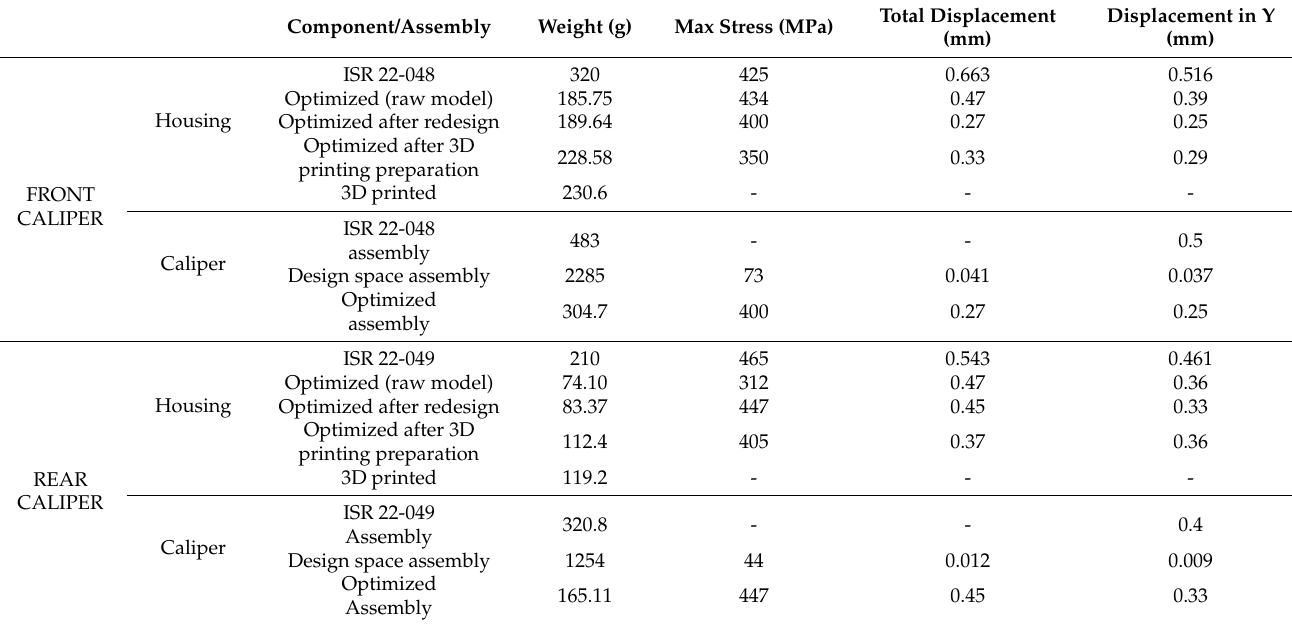
Table 2. The results from the validation